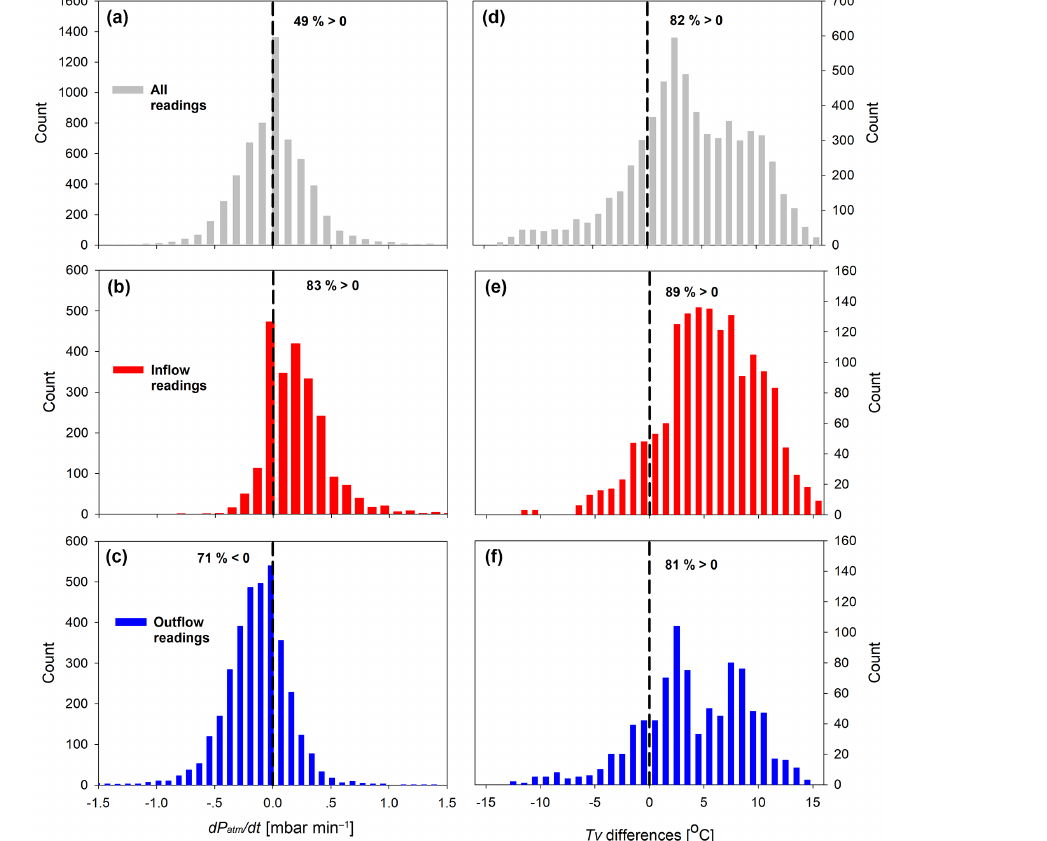
Figure 6. Histograms of changes in atmospheric barometric pressure (d P atm / d t ) and T v difference between the shaft and the atmosphere. The gray color (a, d) represents data from all 42 days of measurement. Red (b, e) and blue (c, f) represent data from the inflow and outflow events, respectively. Positive values of d P atm / d t can drive inflow events from the atmosphere into the underground cavity, whereas negative values can drive outflow events. T v differences ( x axis) are between 12m deep inside the shaft and the